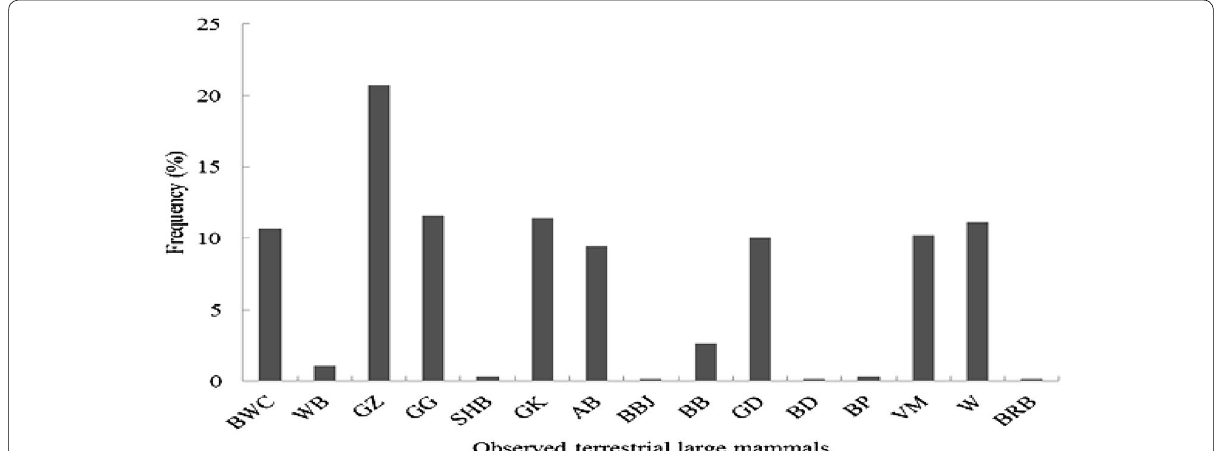
Fig. 3 Frequency distribution of observed terrestrial large mammals of NSNP. BWC black and white colobus, WB Waterbuck, GZ Grant’s zebra, GG Grant’s gazelle, SHB Swayne’s hartebeest, GK greater kudu, AB Anubis baboon, BBJ black-backed jackal, BB Bushbuck, GD Guenther’s dikdik, BD Bush duiker, BP Bush pig, VM Vervet monkey, W Warthog, BRB Bohor